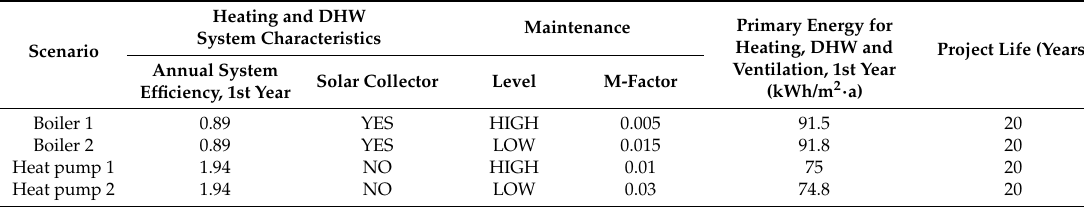
Table 6. Four different heating system scenarios for degradation assessment.